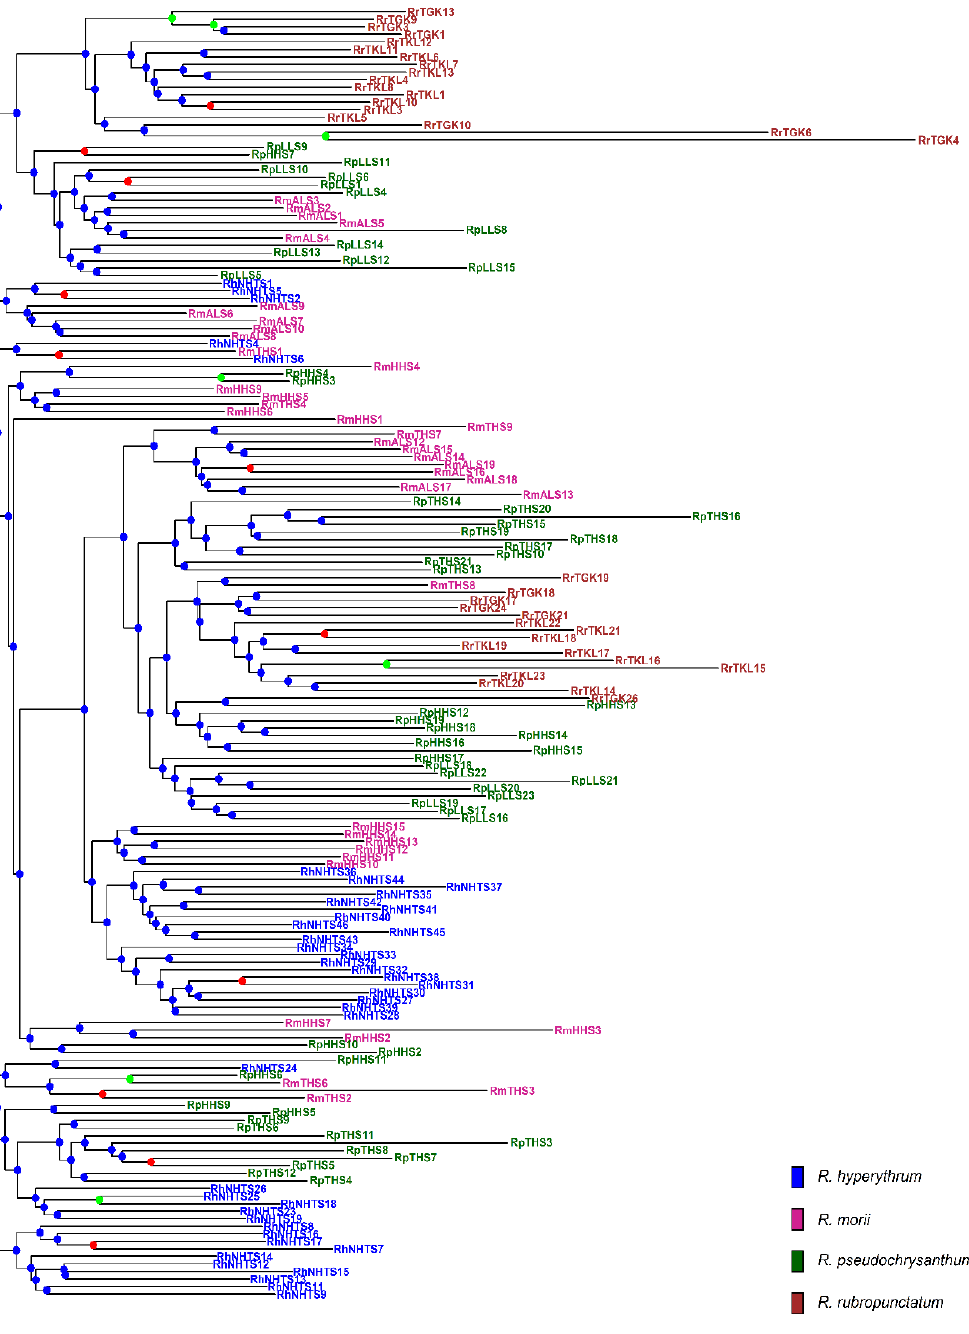
Figure 3. The neighbor-joining (NJ) tree of 171 individuals of four closely related species in the Rhododendron pseudochrysanthum complex based on the total AFLP variation. The NJ tree was generated based on Nei’s genetic distances [33] and 1000 bootstrap replicates were used in calculating bootstrap support values. Tip labels for individuals are colored: R. hyperythrum (blue), R. morii (violet red), R. pseudochrysanthum (dark green), and R. rubropunctatum (brown). For each node, bootstrap support values greater than 70%, between 50% and 70%, and smaller than 50% were coded with green, red, and blue circles, respectively.